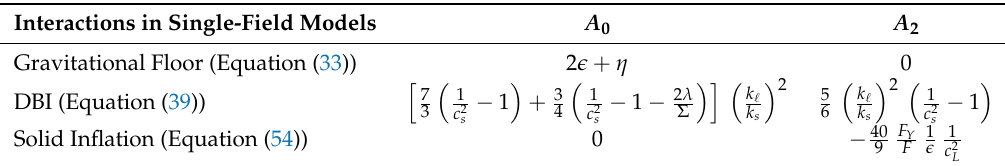
Table 1. List of values of A 2 J from the squeezed limit expansion of Equation (150) for interactions produced in single-field models of inflation. Interactions in Single-Field